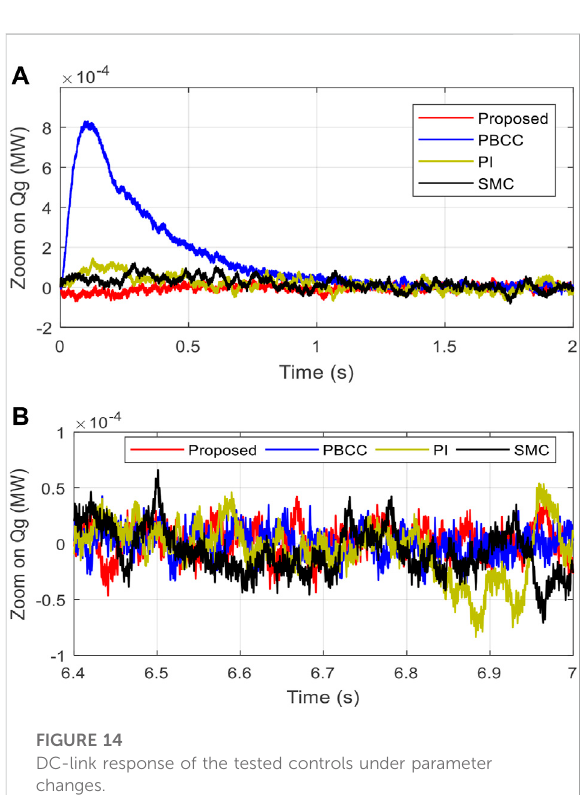
FIGURE 14 DC-link response of the tested controls under parameter changes.